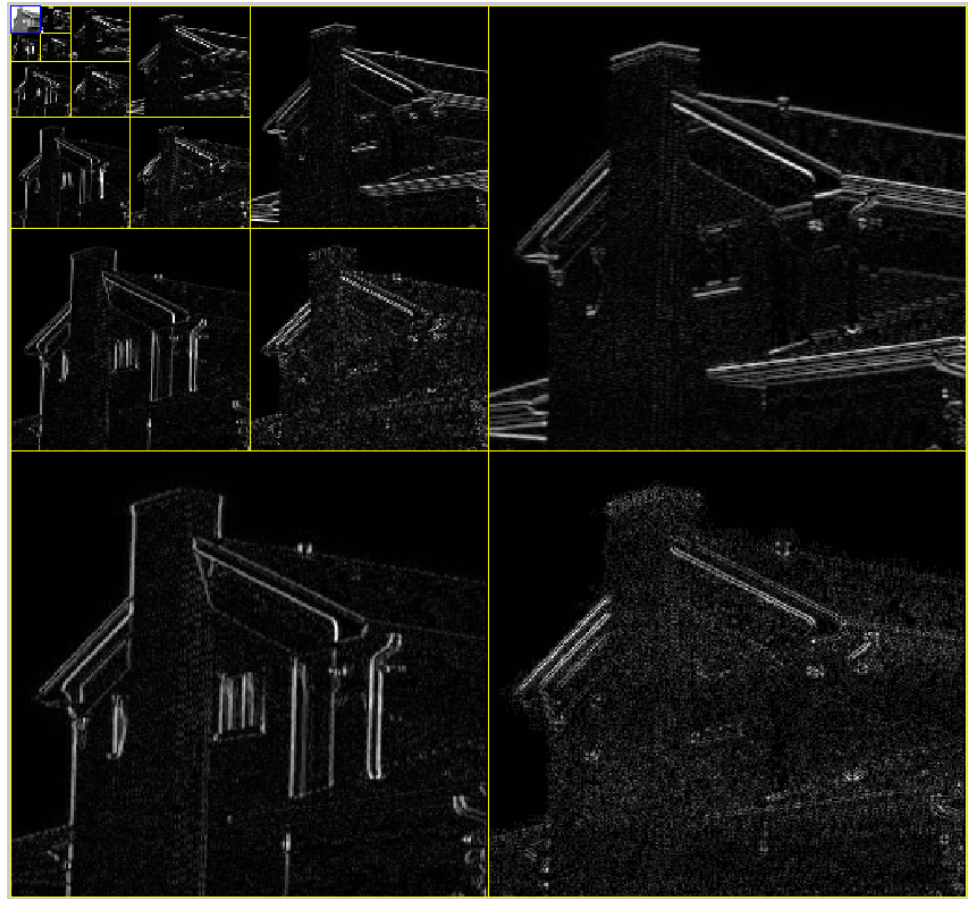
Figure 3. Wavelet decomposition applied to a test image. Six decomposition levels were